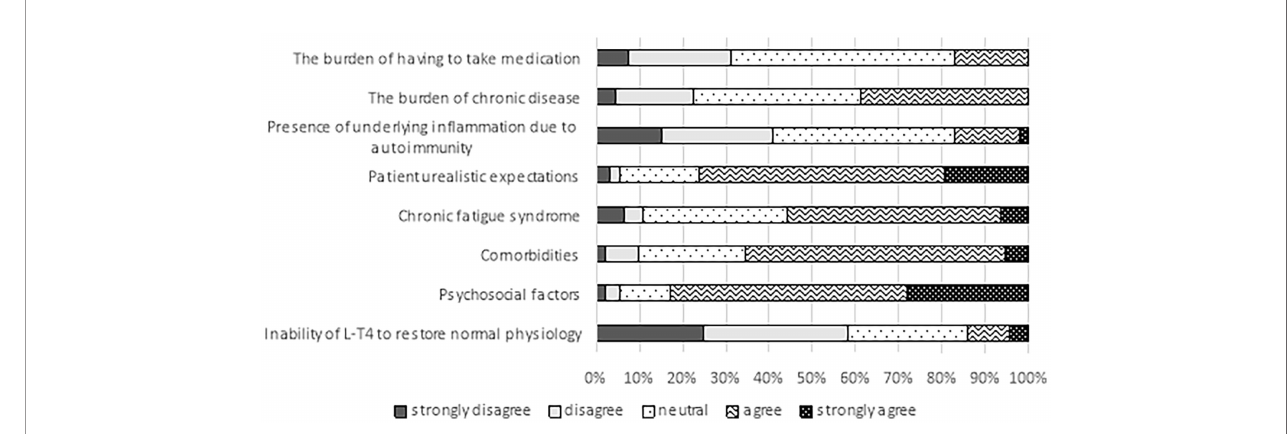
FIGURE 3 | Possible factors explaining persistent hypothyroid symptoms despite biochemical euthyroidism in patients treated with L-T4 (data from 93 respondents, 23 did not answer this question). The same 23 individuals did not respond in Figures 1 – 3